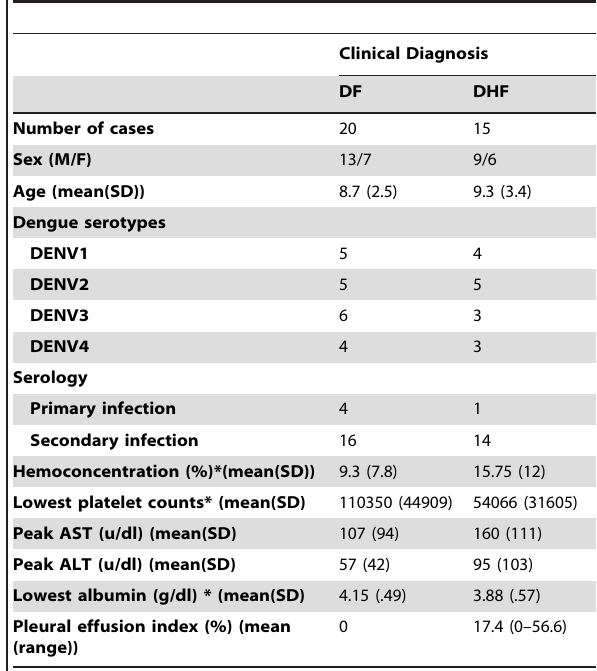
Table 1. Patient